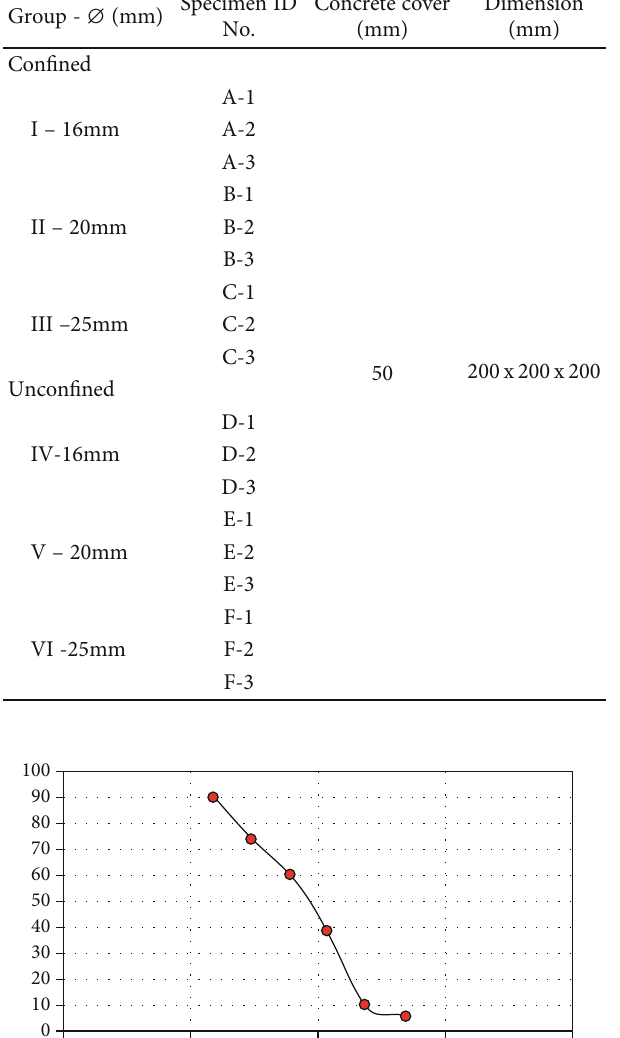
Table 1: Specimen designation.